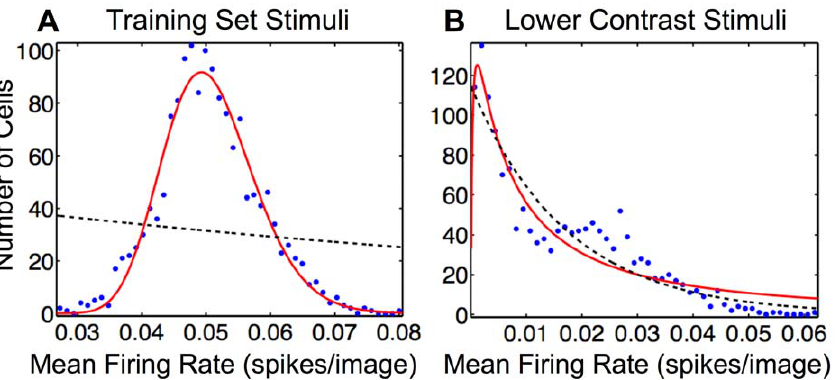
Figure 4. Units in SAILnet exhibit a broad range of mean firing rates, which can be lognormally or exponentially distributed depending on the choice of probe stimuli. (A) Frequency histogram of firing rates averaged over 50,000 image patches drawn from the training ensemble for each of the 1536 units of a SAILnet trained on whitened natural images. All learning rates were set to zero during probe stimulus presentation. A wide range of mean rates was observed, but as expected, the distribution is peaked near p ~ 0 : 05 spikes per image, the target mean firing rate of the neurons. The paucity of units with near-zero firing rates suggests that this distribution is closer to lognormal than exponential. Accordingly, the lognormal least-squares (solid red curve) fit accounts for R 2 ~ 96% of the variance in the data, whereas the exponential fit (black dashed curve) accounts for only 2% . (B) In response to low contrast stimuli, the firing rate distribution across the units (every unit fired at least once) in the same network as in panel (A) was similarly well fit by either an exponential (dashed black curve; accounting for R 2 ~ 88% of the variance in the data) or a lognormal function (solid red curve; accounting for 90% of the variance). The low-contrast stimulus ensemble used to probe the network consisted of images drawn from the training set, with all pixel values reduced by a factor of three.